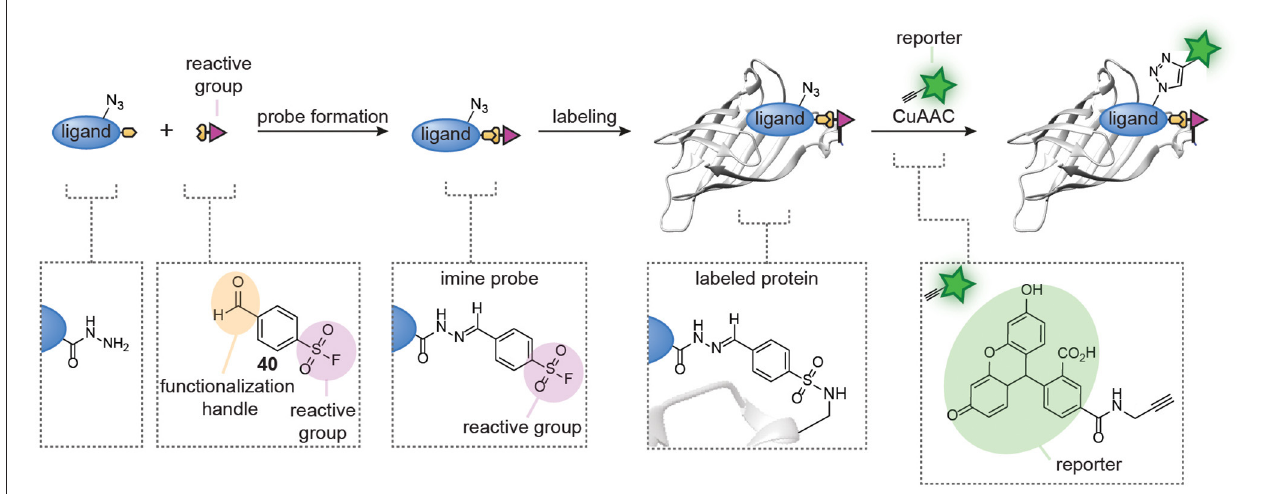
FIGURE 9 | Schematic representation of in situ probe formation with hydrazone chemistry. A hydrazide ligand is reacted with an aldehyde-functionalized reactive group, for example a sulfonyl fluoride ( 40 ), to form a hydrazone probe. The resulting probe is used without further purification. Probe labeling is visualized via a copper-catalyzed click reaction with a reporter